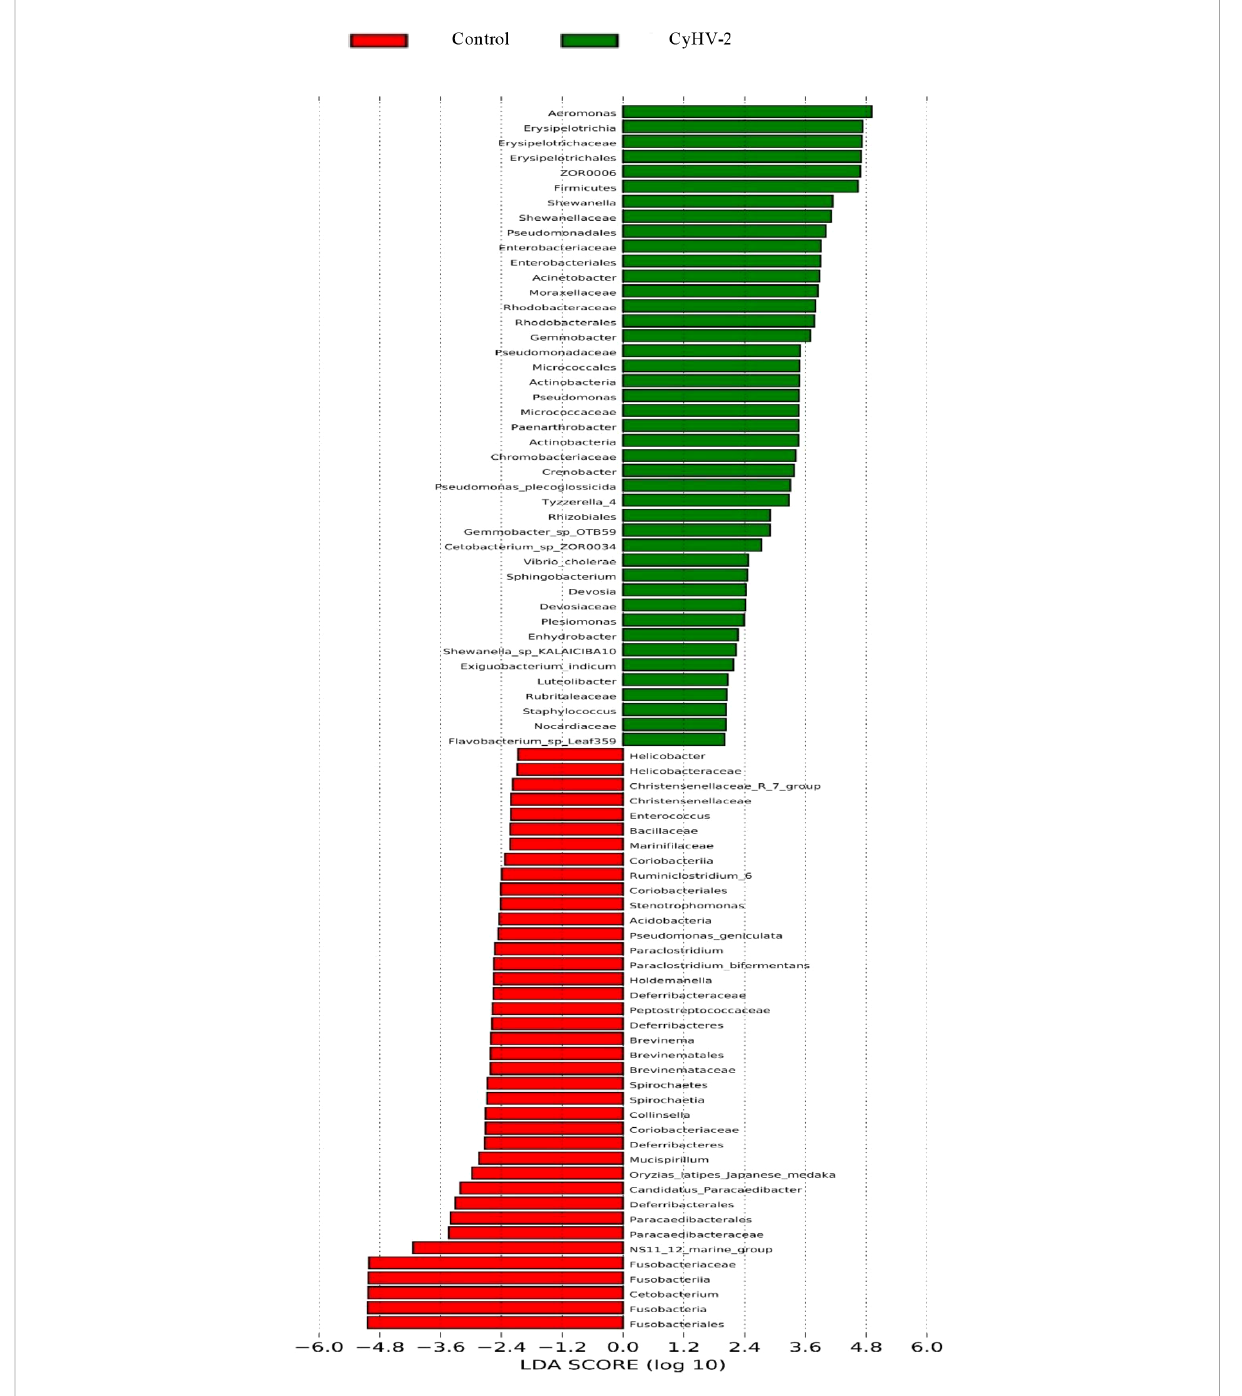
FIGURE 4 Linear discriminant analysis coupled with effect size measurements to identify the most deferentially abundant taxon between control and CyHV-2 infection